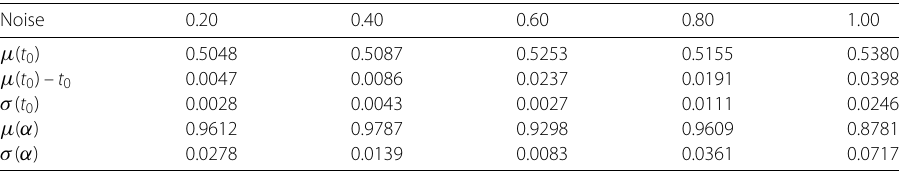
Table 2 Change points inferred for noisy synthetic images. The true value of change point is t 0 = 0.50 where solid circles change into hollow circles with different levels of noise Noise 0.20 0.40 0.60 0.80 1.00 μ ( t 0 ) 0.5048 0.5087 0.5253 0.5155 0.5380 μ ( t 0 ) – t 0 0.0047 0.0086 0.0237 0.0191 0.0398 σ ( t 0 ) 0.0028 0.0043 0.0027 0.0111